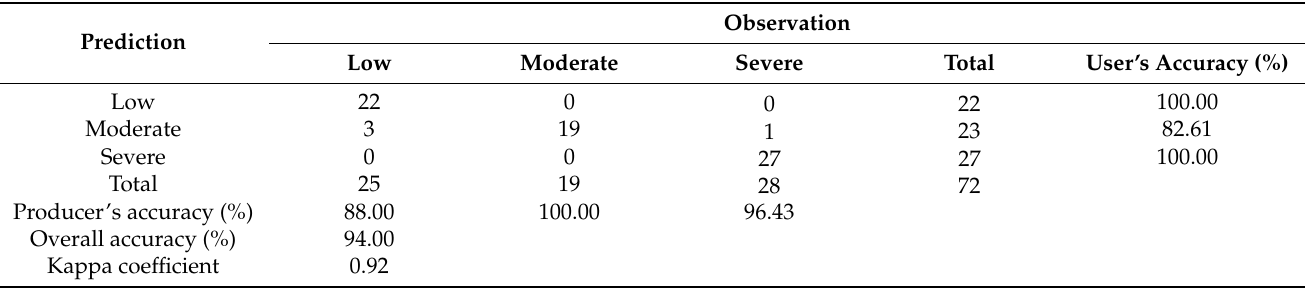
Table 1. Confusion matrix of laboratory-based spectral classification of erosion intensity using a combination of principal component and linear discriminant analysis